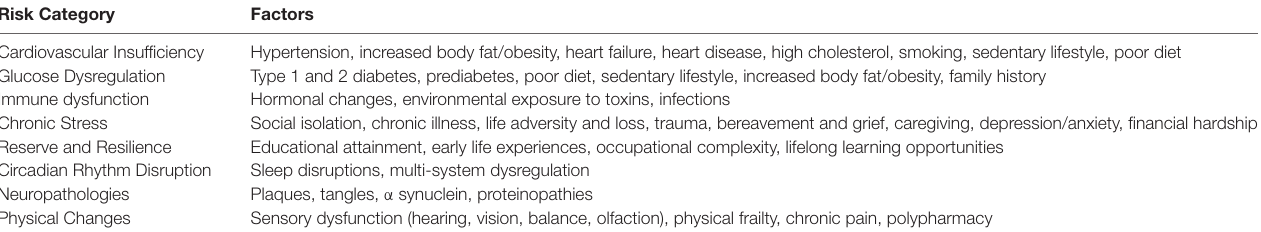
TABLE 1 | Some of the major risk categories for age-related cognitive impairment (ARCI) and cognitive decline, and a list of individual factors that have been associated with each category. Risk